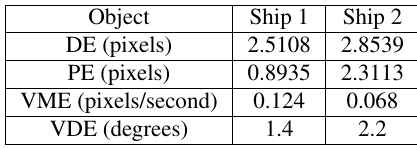
Table 3. the evaluation of the movement prediction